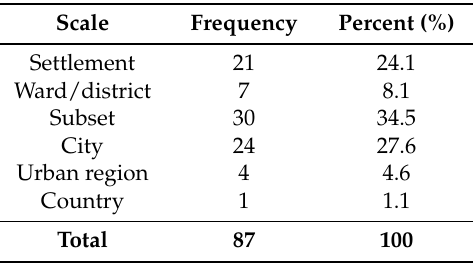
Table 6. Spatial extent (scale) of slum-mapping case studies found in literature.